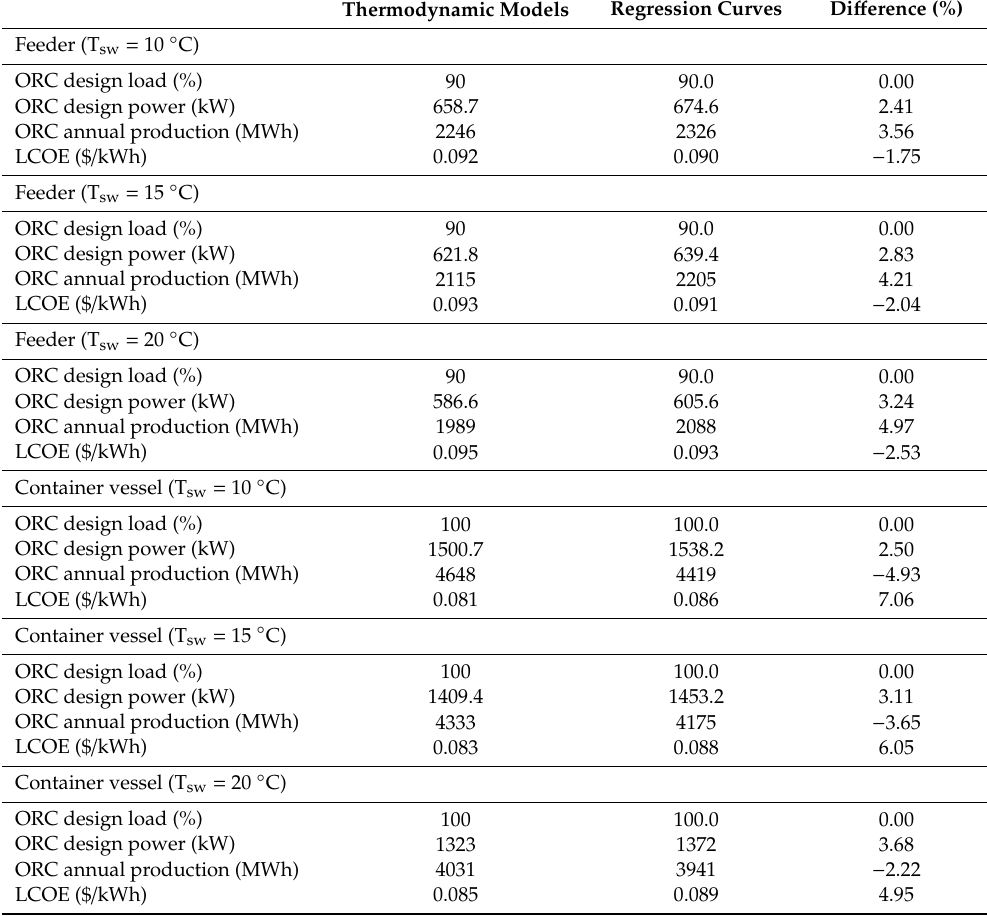
Table 6. Comparison between the solutions attained using the thermodynamic models and the regression curves (model #1): energy production maximization